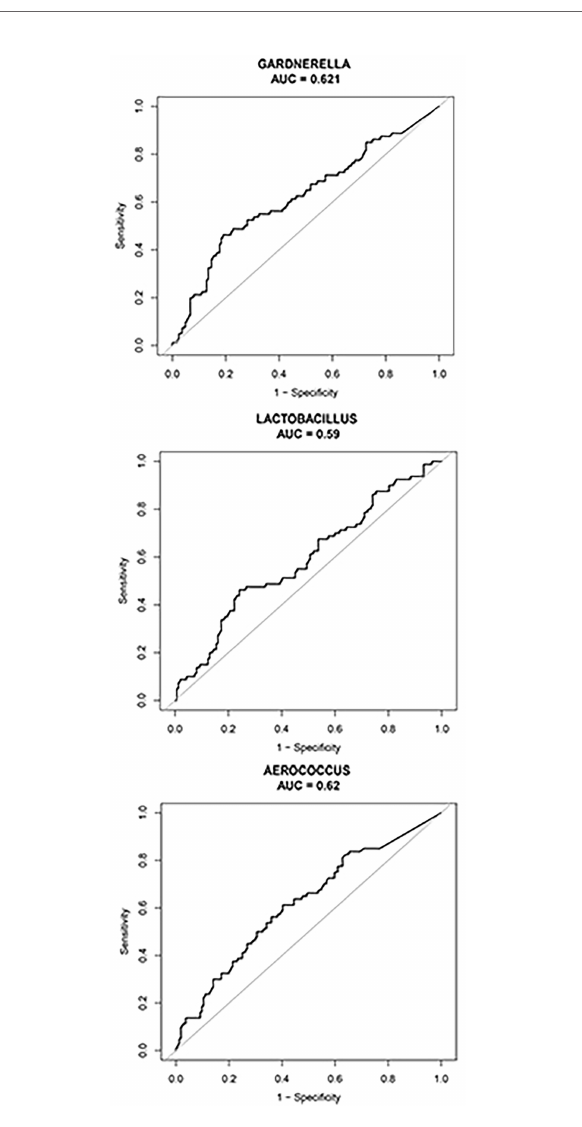
FIGURE 5 | ROC was used to assess the diagnostic value of the Gardnerella , Lactobacillus , and Aerococcus genera. The black curve indicates average AUC for the three bacterial genera indicated. The diagonal lines mark an area under the receiver operating characteristic curve of